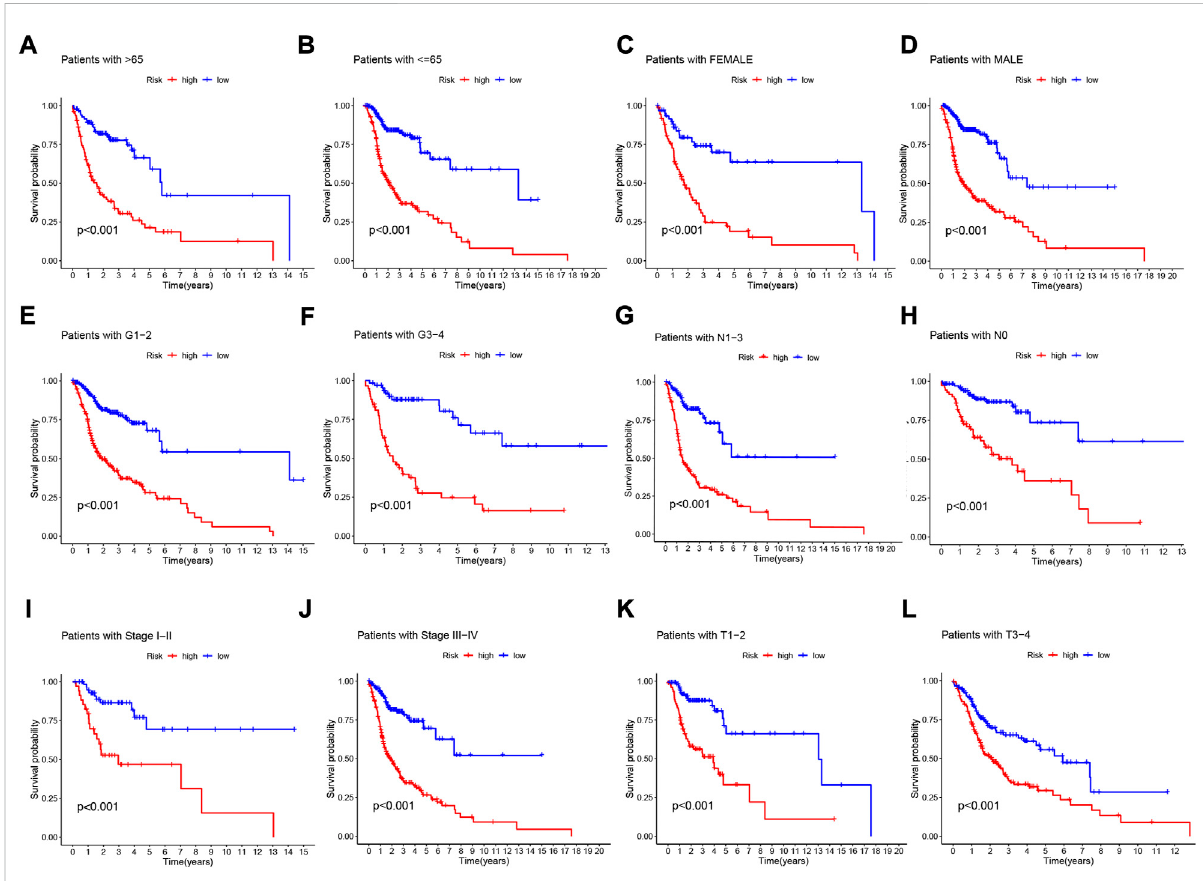
FIGURE 7 PrognosticpoweroftheNFRGsriskmodelforoverallsurvivalformultipleHNSCCsubtypes. (A) Age > 65 years. (B) Age ≤ 65 years. (C) Female. (D) Male. (E) Grade I-II. (F) Grade III-IV. (G) N0. (H) N1-3. (I) Stage I-III. (J) Stage III-IV. (K) T1-2. (L)